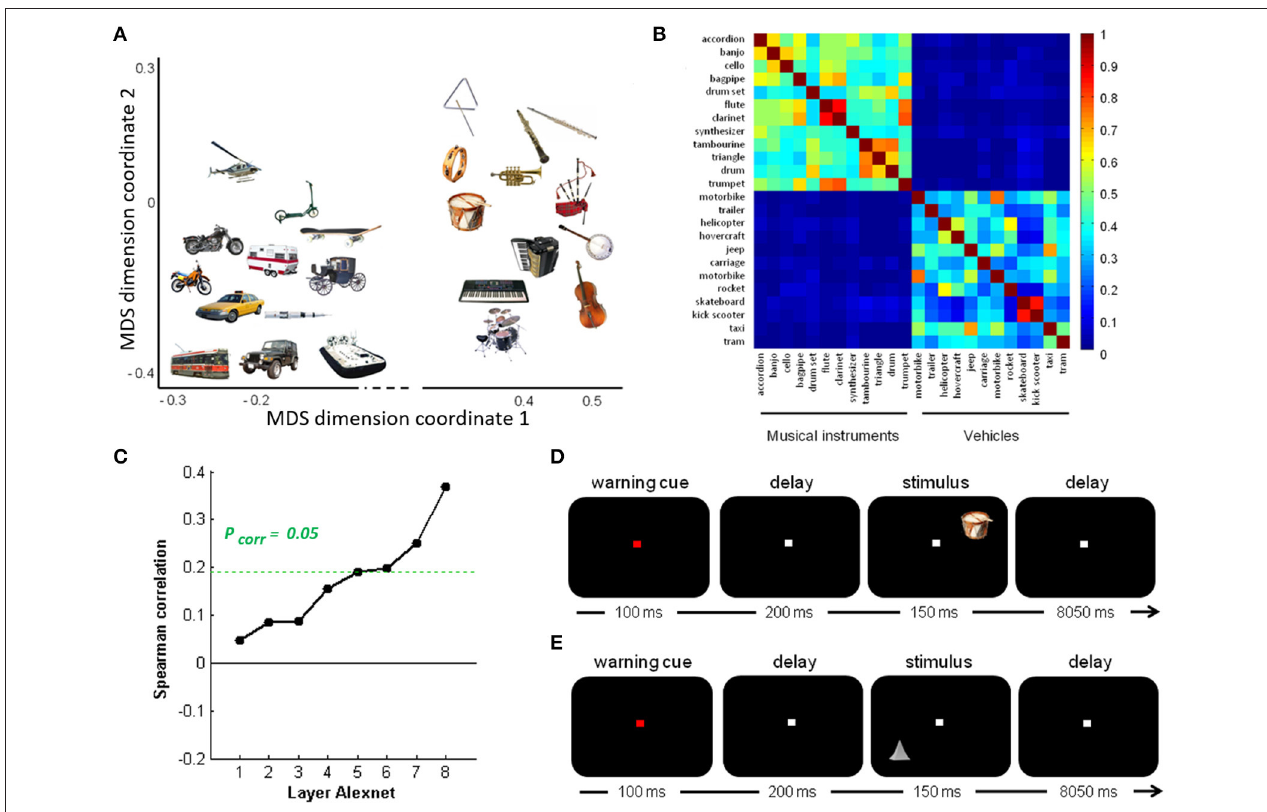
FIGURE 1 | Overview of stimuli and design. (A) Semantic similarity between the real-life objects. Non-metric multidimensional scaling of the entities was performed based on an entity-by-entity dissimilarity matrix. To this end, the distance between each pair of rows in the concept-feature matrix was calculated with [1 − cosine similarity] as distance metric (De Deyne et al., 2008). The x and y values are in arbitrary units. (B) Semantic similarity matrix of the real-life stimuli. This matrix was derived from a feature generation task with subsequent scoring of the applicability of the most frequently generated features. (C) Deep learning. Spearman correlation between the semantic similarity matrix and the similarity matrices for the pictures for the eight layers of Alexnet. Statistical significance was evaluated by 10,000 random permutation labelings (green dotted line). Statistical threshold of P < 0.05, corrected for the number of layers. (D) Stimulus presentation: Schematic of the stimulus presentation with a sample real-life object as used in the main experiment and (E) a sample geon as used in the geon experiment.